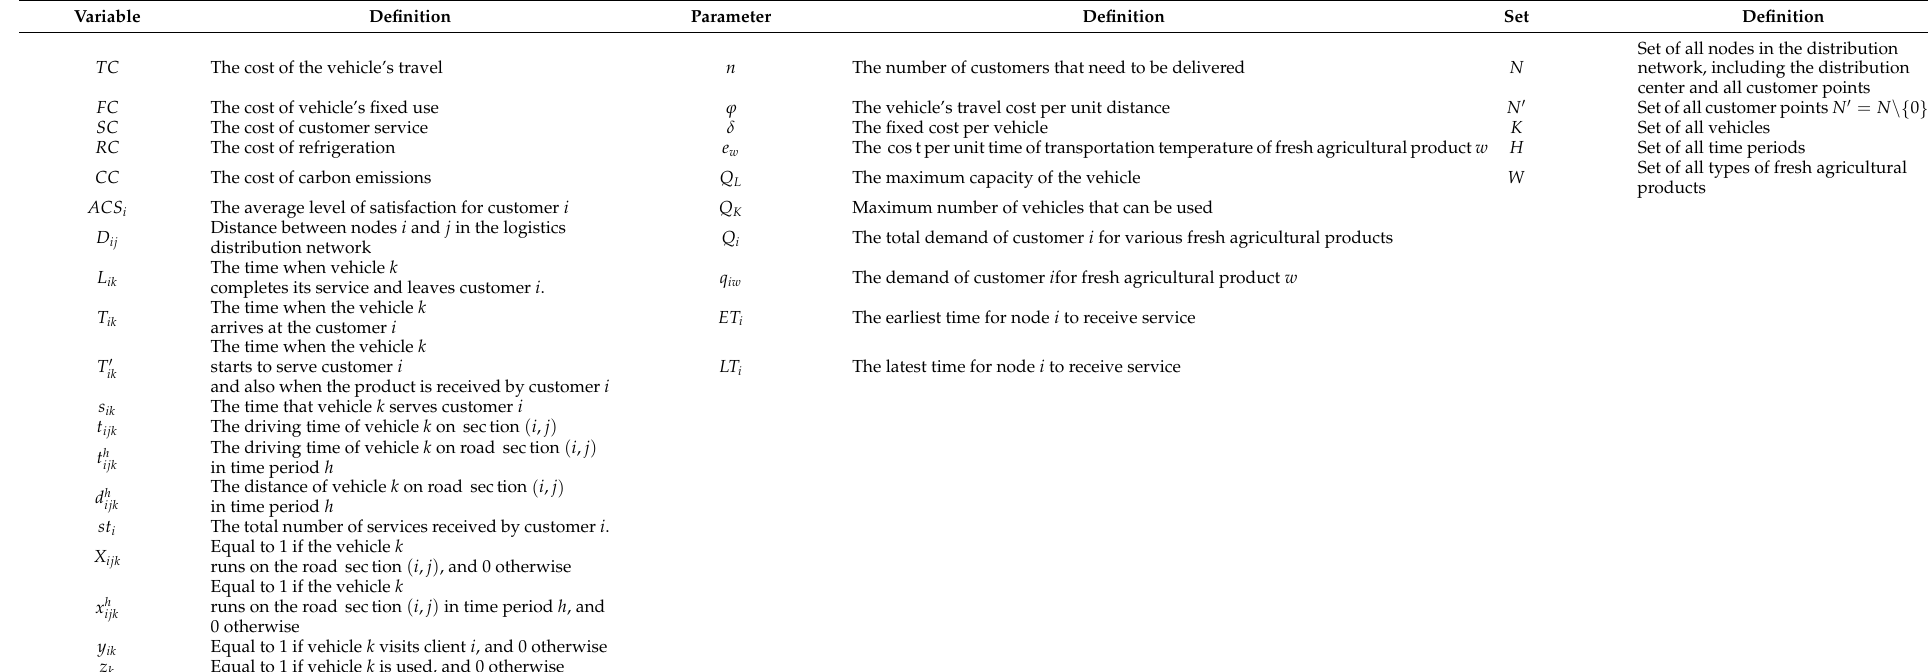
Table 1. Symbol definitions in the TDSDGVRPMTW